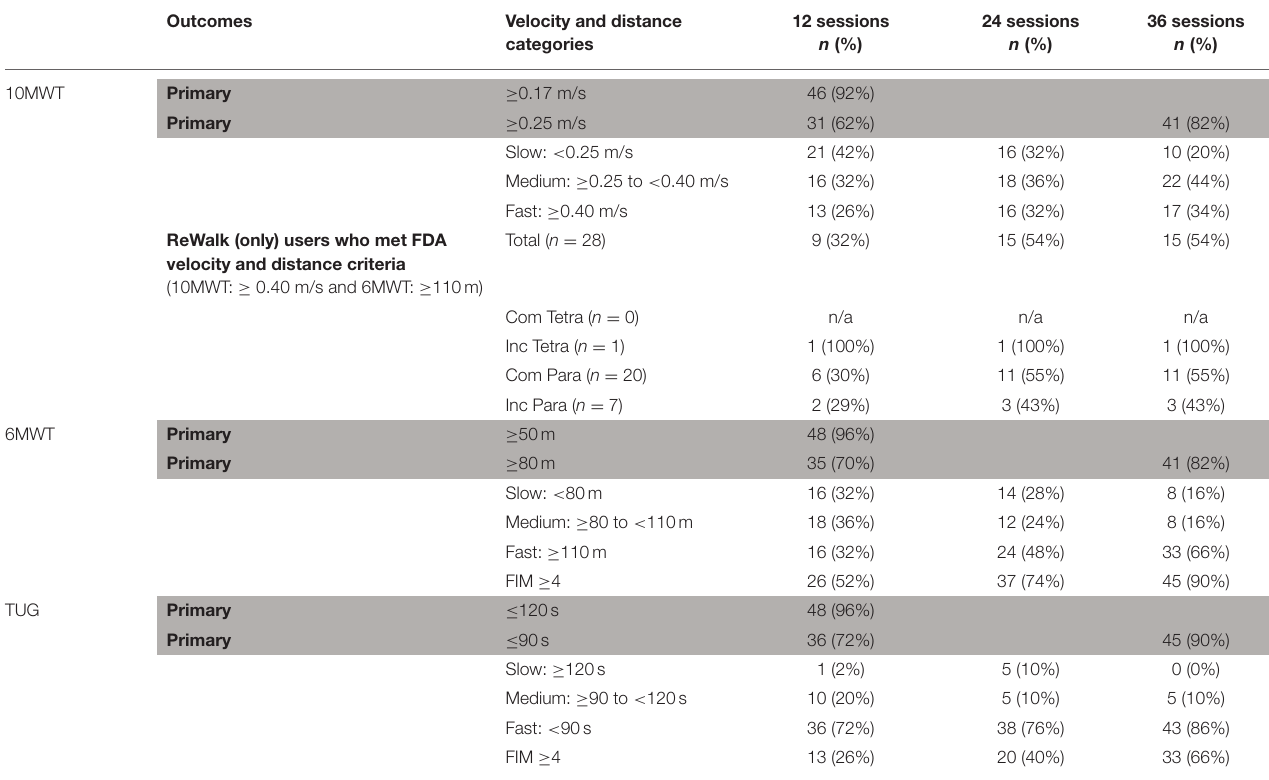
TABLE 5 | Number and percent of participants by walking velocity categories. Outcomes Velocity and distance